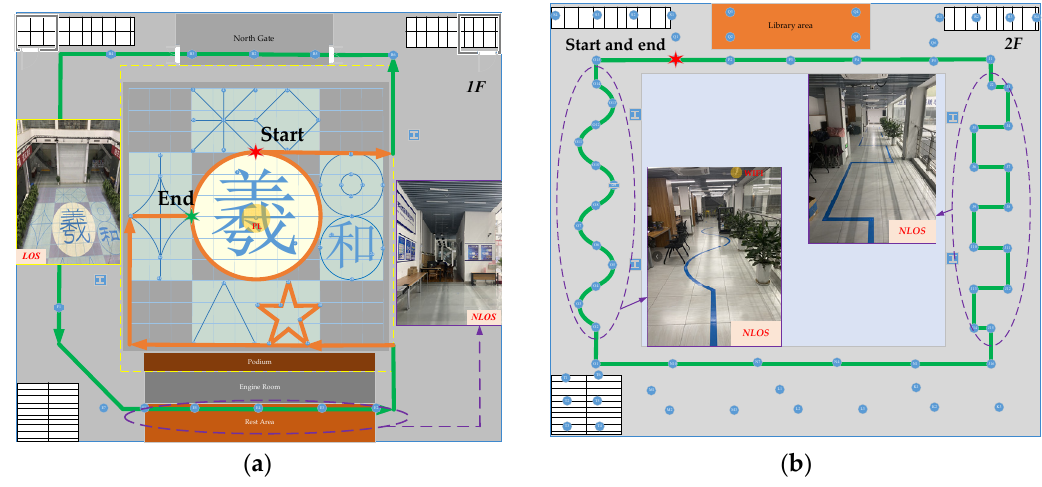
Figure 14. Test environment: ( a ) 1st floor of test field; ( b ) 2nd floor of test field. The orange test track planned on the left side of Figure 14 is the radio signal LOS area, the green track is the NLOS area and the total test length is about 156 m. The right side of Figure 14 is the second-floor area. It will penetrate the glass to reach the receiving terminal, and the length of the test track is about 116 m. Among them, the blue points are the calibration points and test points, and the star points are the starting and ending points of the test track.